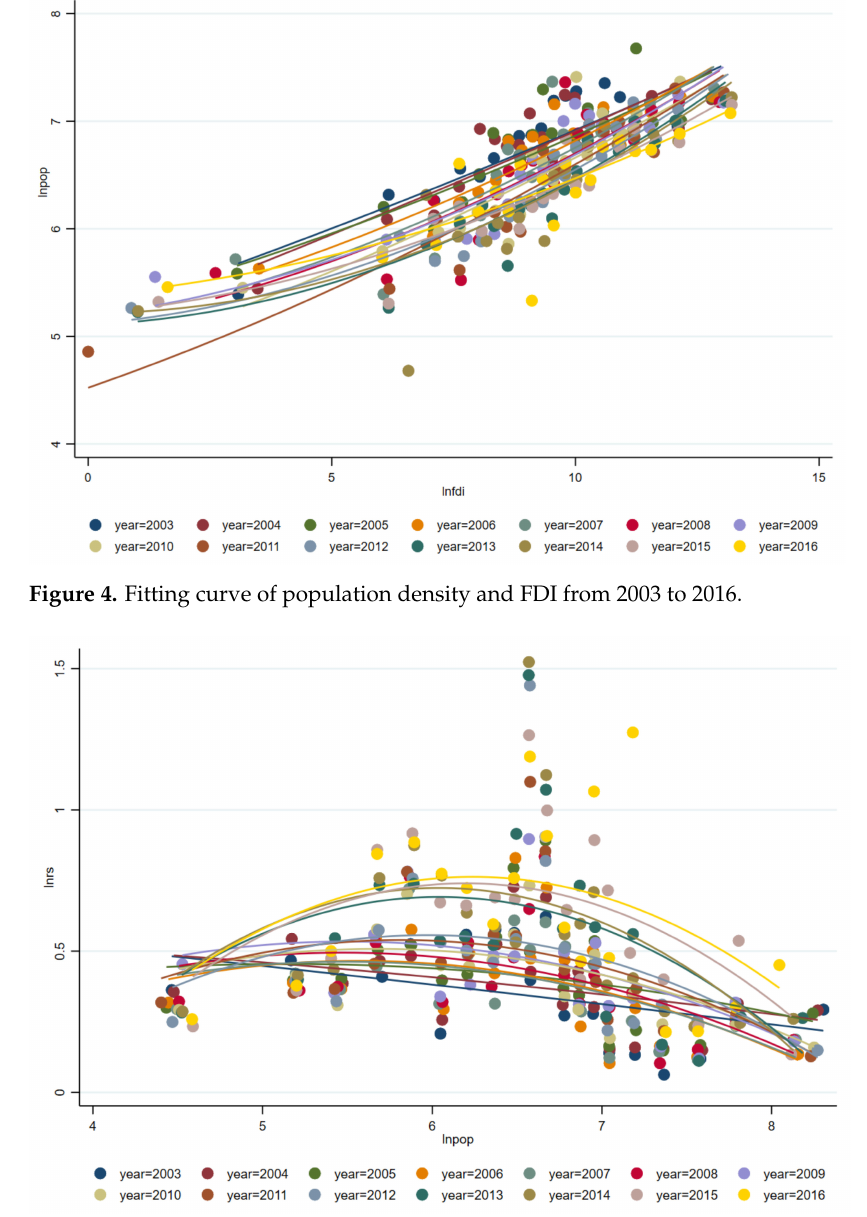
Figure 5. Fitting curve of industrial structure rationalization and population density from 2003 to